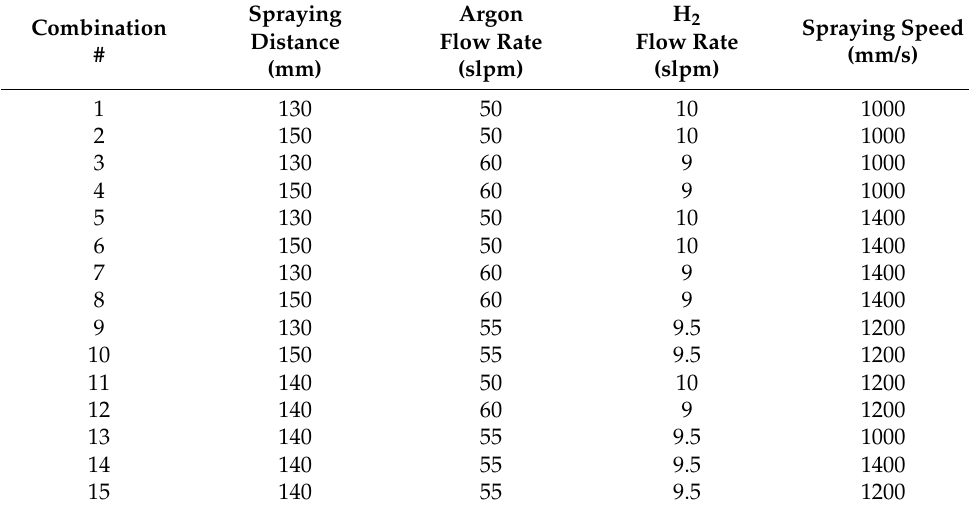
Table 1. Parameter combinations for Ni-Al spraying on an aluminum substrate by